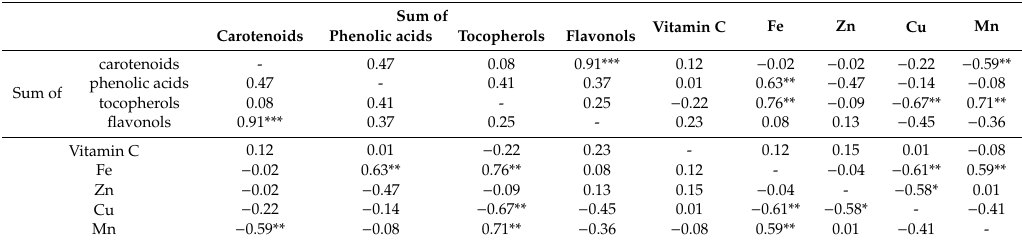
Table 8. Results of the correlation analysis between the contents of selected compounds with antioxidant properties in Cucurbita moschata Duchesne.